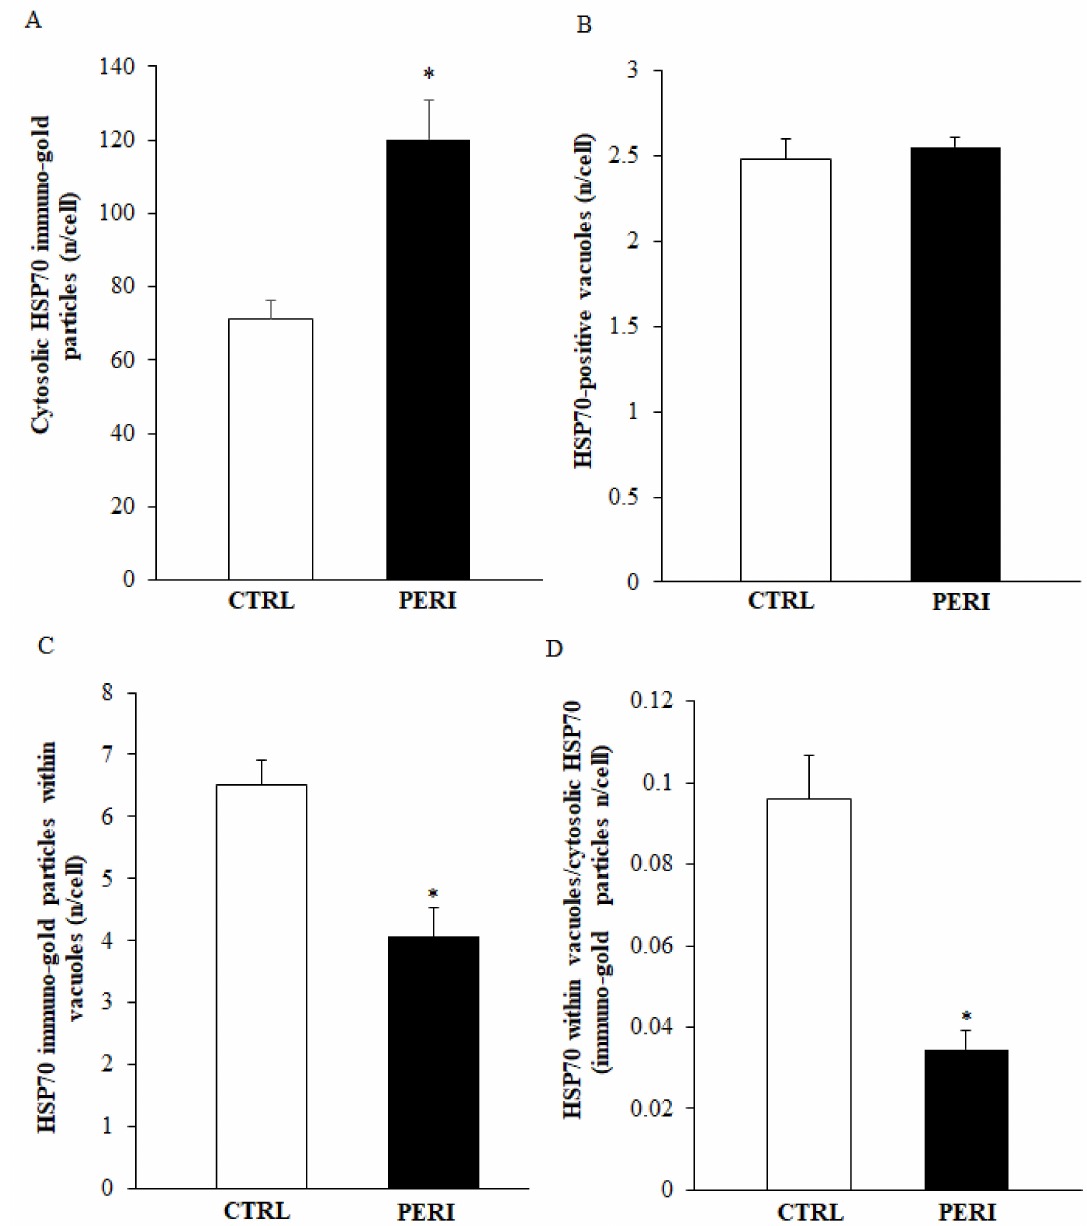
Figure 7. Representative polarization graphs for HSP70 in the ventral cortex. Graphs report the cytosolic amount of HSP70 ( A ), the HSP70-positive vacuoles ( B ), the HSP70 immuno-gold particles within vacuoles ( C ), and the ratio of vacuolar to cytosolic HSP70 immuno-gold particles ( D ). Ventral placement of area penumbra was dissected in the ipsilateral hemi- encephalon of ischemic mice ( n = 3); analogous area was analyzed from the contralateral side. * p ≤ 0.05 compared with the contralateral ventral